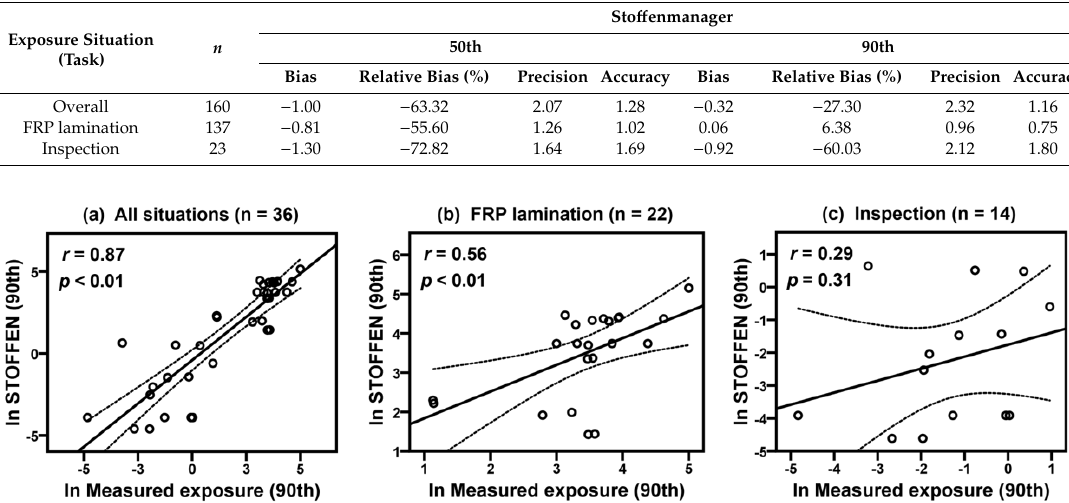
Table 6. Bias, relative bias, precision, and accuracy for historical exposure measurements and the model estimations using Stoffenmanager (50th and 90th percentiles).